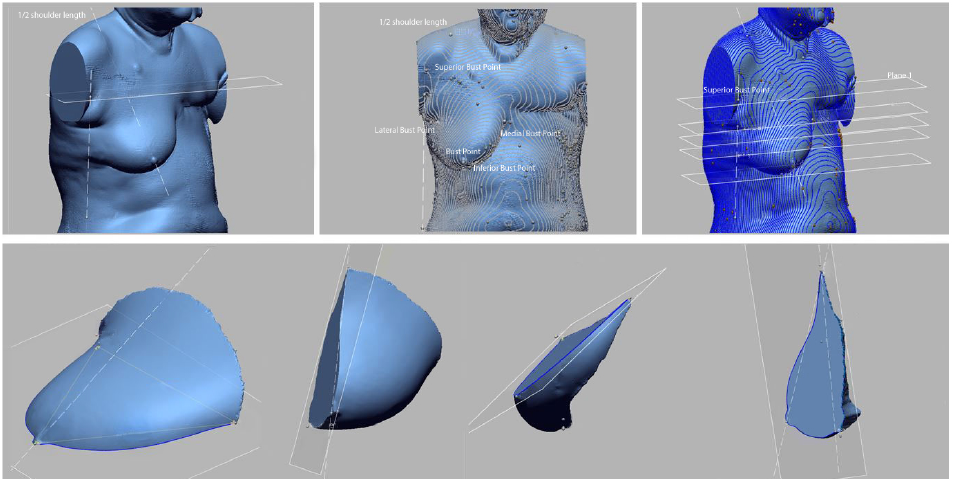
Figure 5. Detailed breast item measurement process of